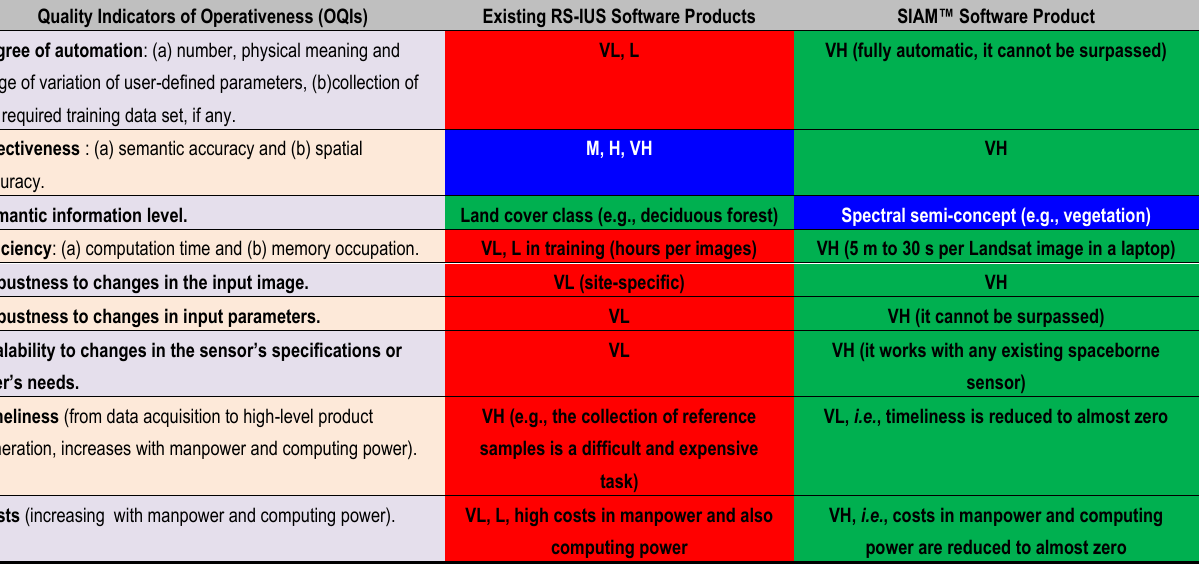
Table 5. Previously shown in [23]. OQIs of SIAM™ in comparison with those of state-of-the-art RS-IUSs. Legend of fuzzy sets: Very Low (VL), Low (L), Medium (M), High (H) and Very High (VH). Legend of color highlights: Red: L, VL; Blue: M; Green: H, VH. Quality Indicators of Operativeness (OQIs) Existing RS-IUS Software Products SIAM™ Software